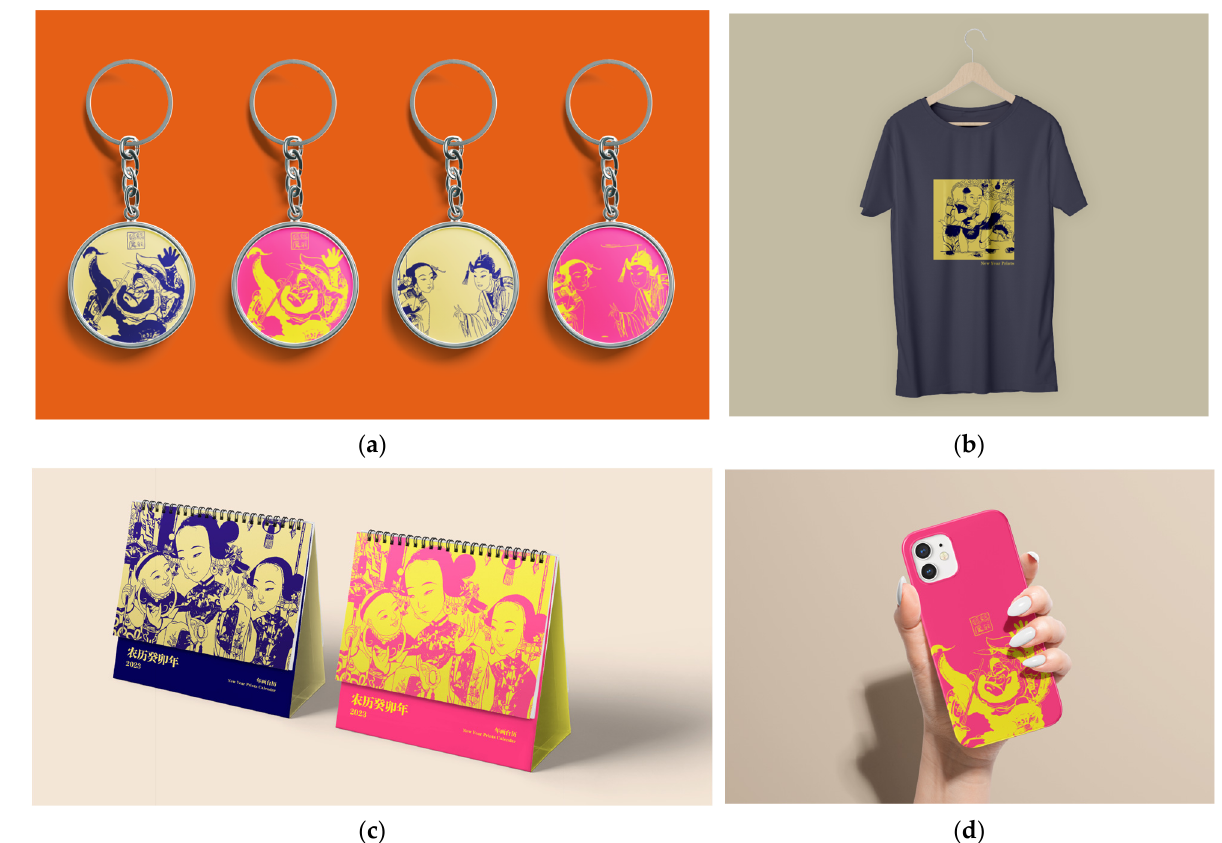
Figure 17. Cultural and creative products designed and developed by researchers: ( a ) keychain, ( b ) T ‐ shirt, ( c ) desk calendar, and ( d ) phone case.